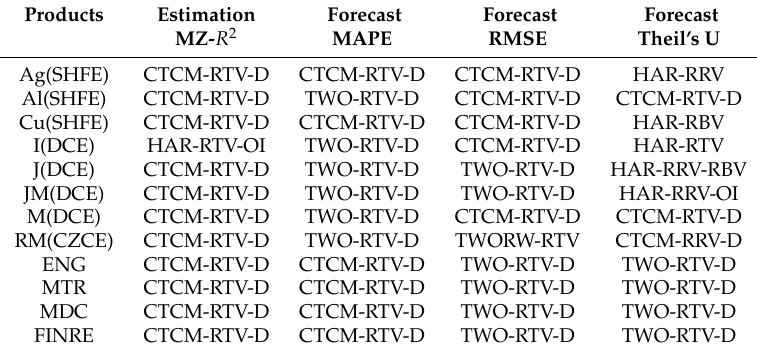
Table 8. The most efficient